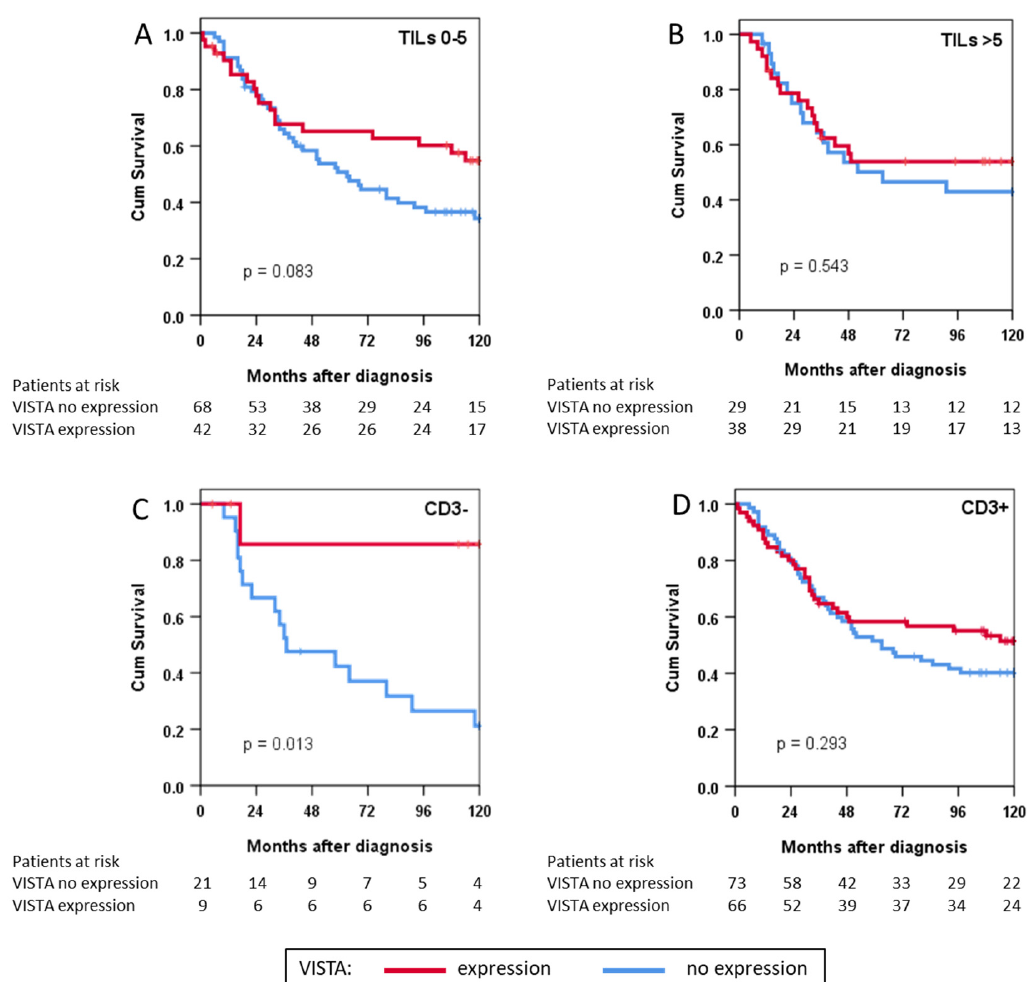
Figure 4. Survival depicted as Kaplan-Meier curves in immunophenotype subgroups of patients with either ( A ) low or ( B ) high tumour-infiltrating lymphocyte (TIL) counts and with ( C ) negative or ( D ) positive CD3 expression; Cum: cumulative.